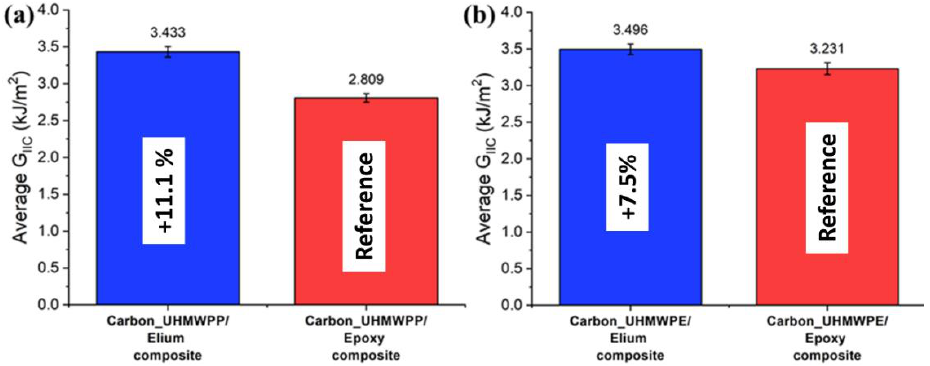
Figure 17 . Average critical energy release rates for ( a ) Carbon_UHMWPP ( b ) Carbon_UHMWPE composites configurations .